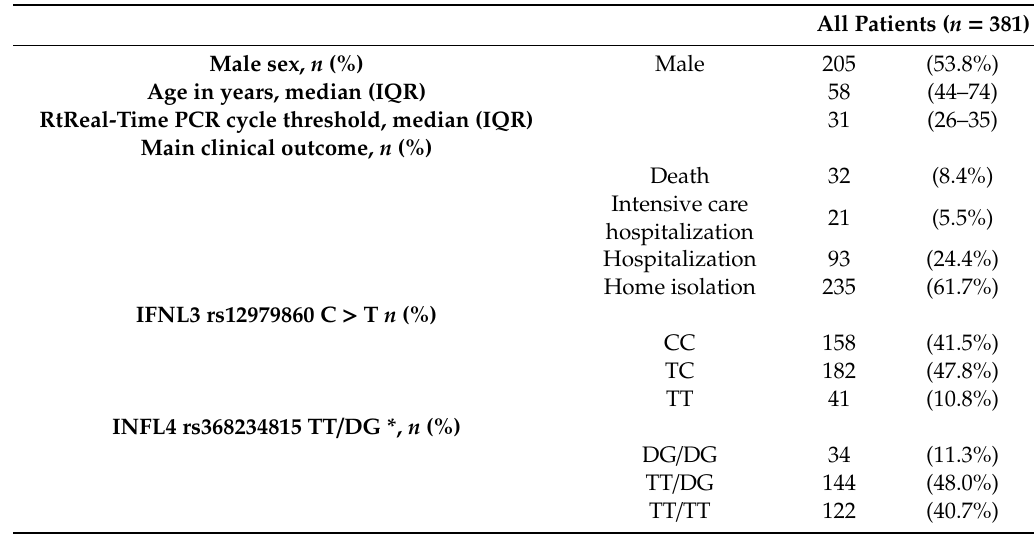
Table 1. General characteristics of the patients.